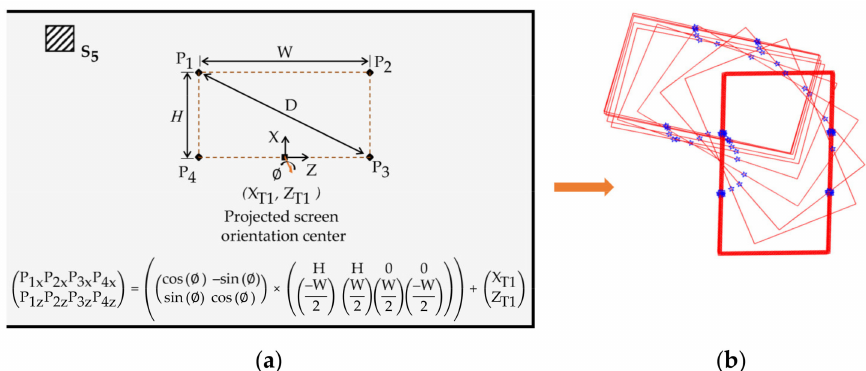
Figure 5. Ground projection on S 5 , finding the boundaries of the projected screen while encountering USAP rotation around its local Z’-axis: ( a ) Schematic of floor projection; ( b ) test result for projection boundary estimation with different orientation